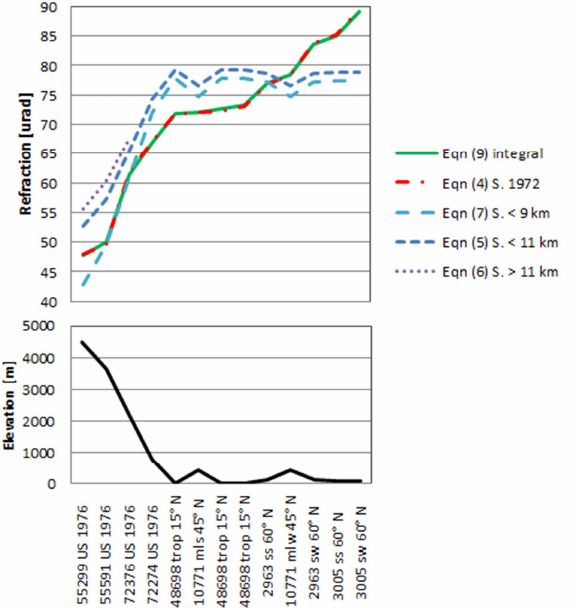
Figure 2. Comparison of the atmospheric refraction at 10 km camera height for all sites using different methods.